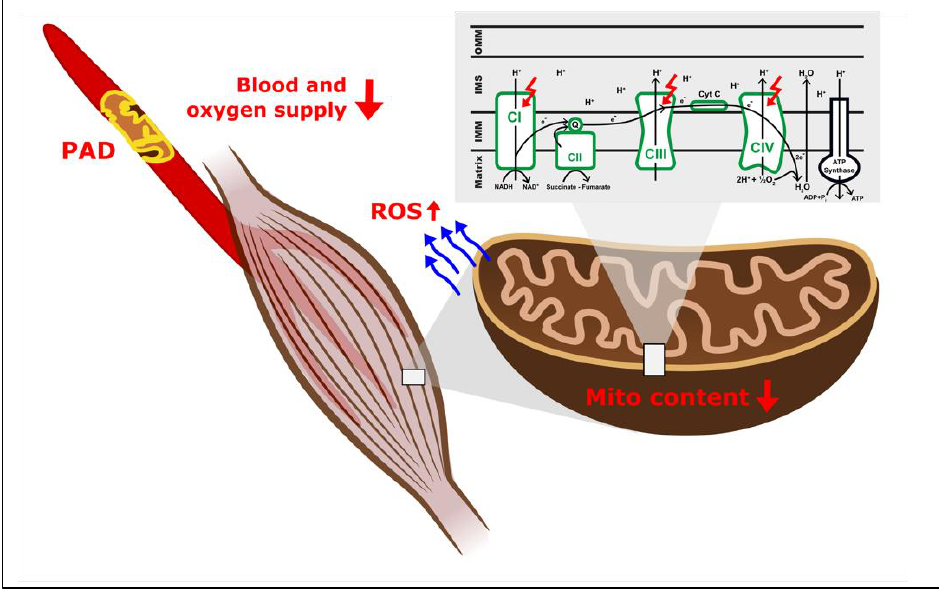
Figure 1. Alterations of mitochondrial function as a result of decreased blood and oxygen supply in PAD. ADP – adenosine diphosphate; ATP – adenosine triphosphate; CI – complex I; CII – complex II; CIII – complex III; CIV – complex IV; Cyt C – cytochrome C; e - - electron; H + - proton; H 2 O – water; IMM – inner mitochondrial membrane; IMS – intermembrane space; O 2 – oxygen; NADH/NAD + - nicotinamide adenine dinucleotide; OMM – outer mitochondrial membrane; PAD – peripheral arterial disease; P i – inorganic phosphate; Q – ubiquinone; ROS – reactive oxygen species.